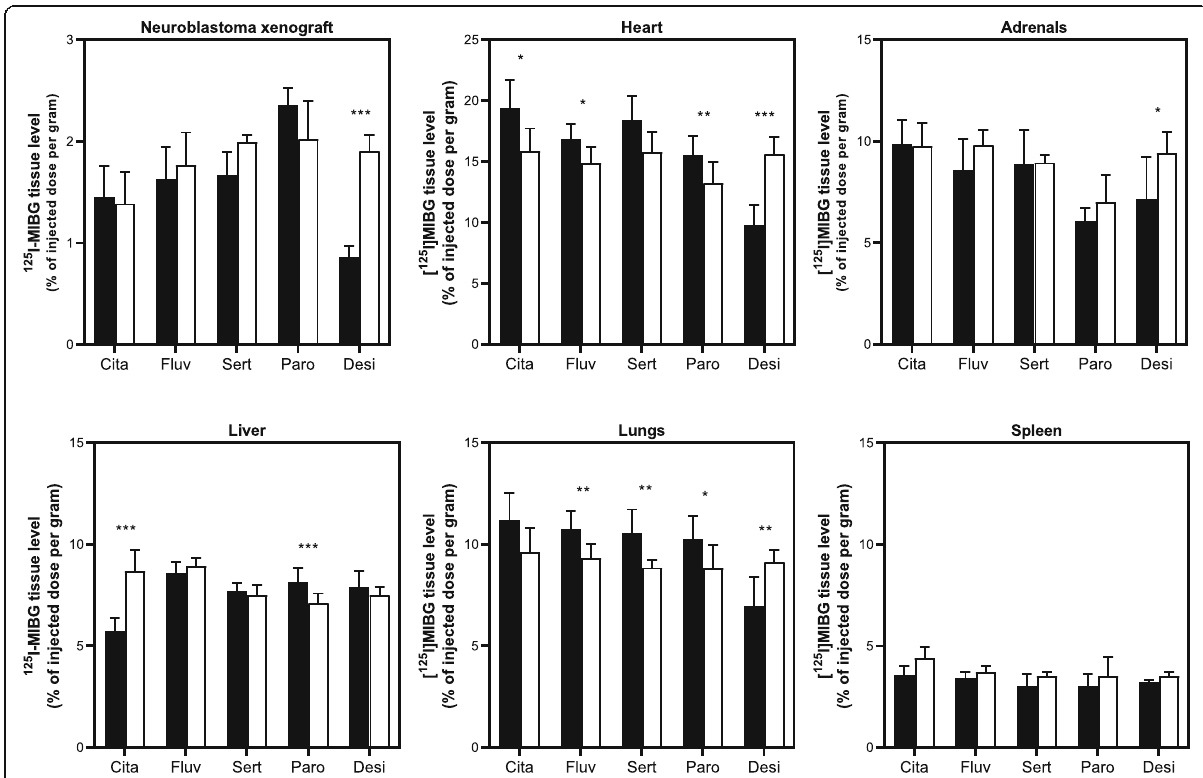
Fig. 6 The in vivo effect of SSRIs and desipramine on [ 125 I]MIBG levels in neuroblastoma xenografts and normal tissues. Before [ 125 I]MIBG injection, mice received either an inhibitor (black bars) or sodium chloride (white bars; control). From left to right, the results of citalopram (20 mg/kg), fluvoxamine (50 mg/kg), sertraline (20 mg/kg), paroxetine (2 mg/kg), and desipramine (20 mg/kg) are shown. Data represent mean + SD with n = 3 – 6 for fluvoxamine, n = 4 for sertraline, n = 4 – 7 for desipramine, and n = 7 – 9 for citalopram. Please note the different scales of the Y - axis. Asterisks were used to indicate significance levels: * p < 0.05, ** p ≤ 0.01, and *** p ≤